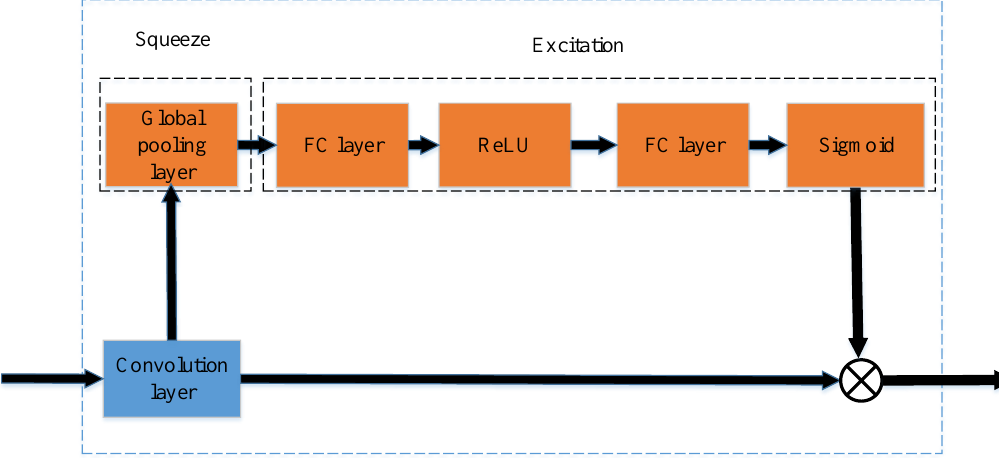
Figure 5. The schematic of squeeze and excitation block, including the squeeze operation and excitation operation.